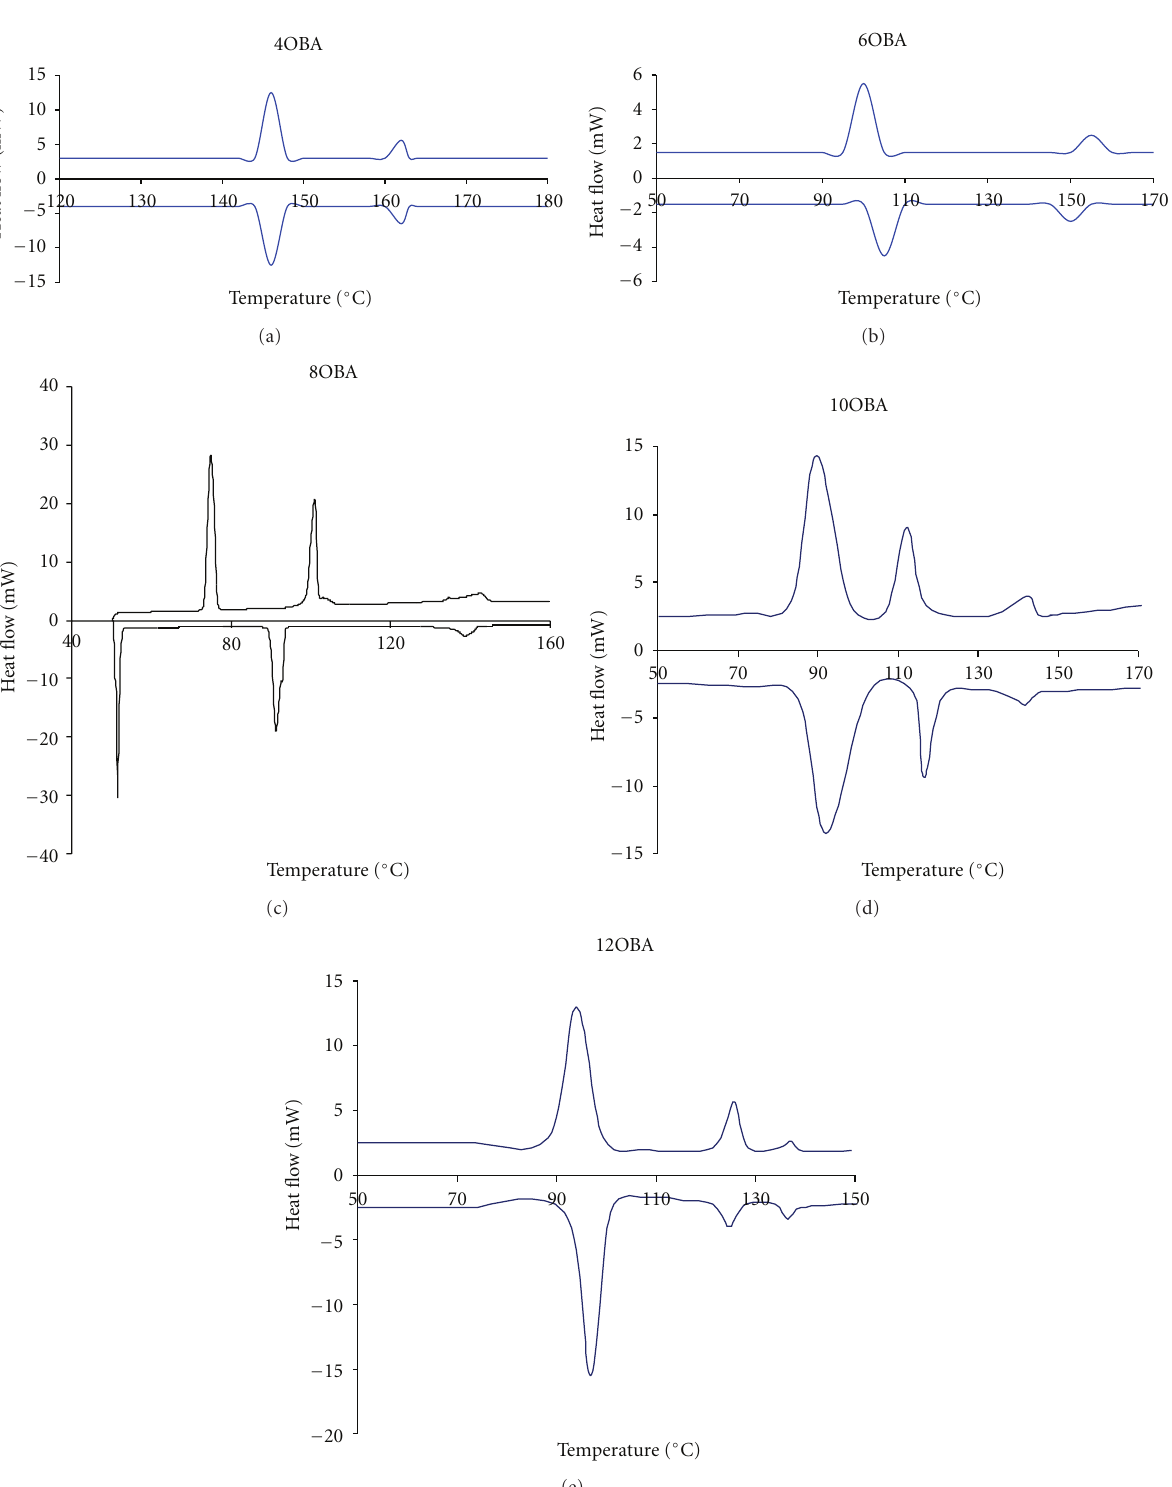
Figure 10: DSC thermograms of p , n -alkyloxybenzoic acid mesogens, (a) n = 4, (b) n = 6, (c) n = 8, (d) n = 10, and (e) n =